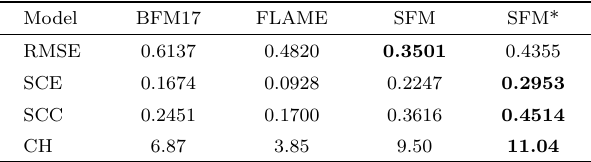
Table 3 Comparasion of the model representation ability and its shape parameter separability with BFM17 [14] and FLAME [13] in Bosphorus database. The SFM* is the SFM finetuned with 2D data Model